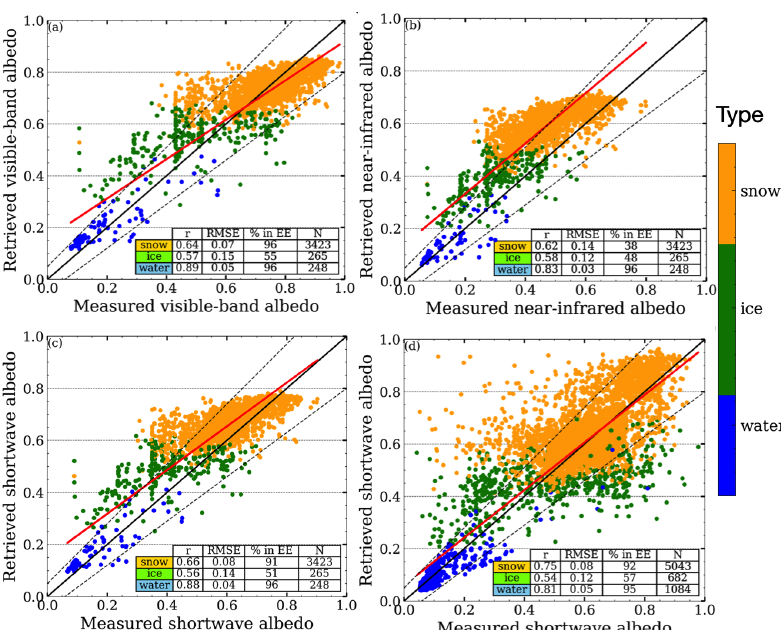
Figure B2. The same as Fig. 4 but with the surface type represented by color. In addition, the lower-right corner of each panel displays data for each surface type ( r , RMSE, f EE ≤ 15 , and N